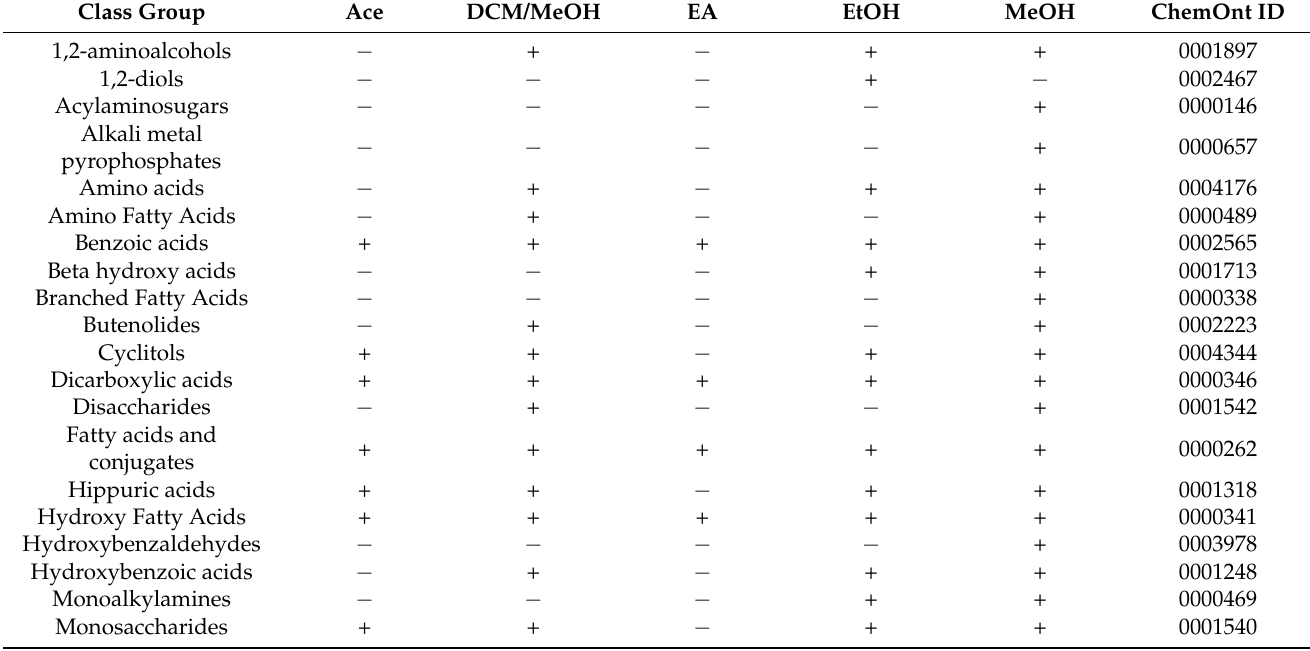
Figure 9. ( a ) Over Representation Analysis (ORA) Bar chart and ( b ) pie chart of the chemical classification of the total metabolites identified in the five E. foeminea crude extract samples using GC–MS via metabolite set enrichment analysis (MSEA). Colors in the bar plot describe the p -value. The red and orange colors signify the high and low values, respectively. The lines indicate the enrichment ratio, which was computed by hits/expected, where hits = observed hits and expected = expected hits. The colors in the pie chart designate each chemical group relative to the total number of compounds. Table 3. Qualitative screening of the top compound classes present in the different solvent crude extracts of E. foeminea analyzed by